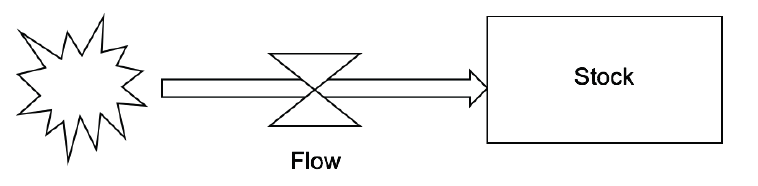
Fig. 2. Simple stocks and flow structure (Richardson,